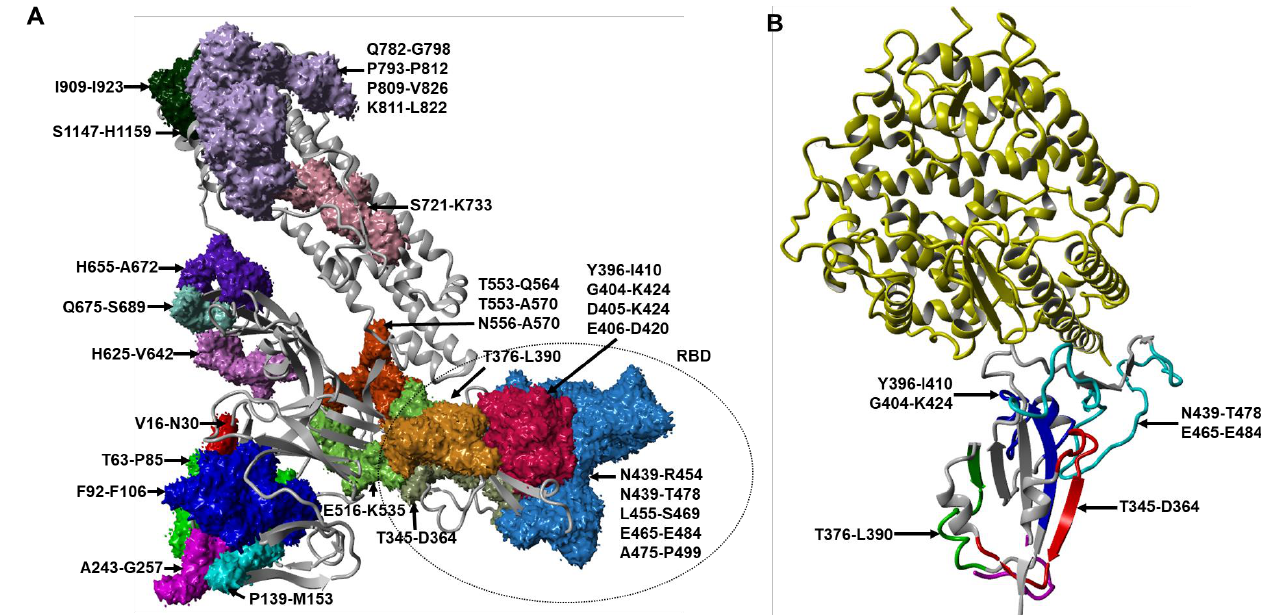
Figure 2. ( A ) The localization of B-cell epitopes mapped on the SARS-CoV-2 S monomer in closed conformation are represented by the amino residue number (PDB ID: 6ZB5/A). ( B ) Locations of B-cell epitopes targeted by monoclonal antibodies in the structure of ACE2 in complex with the SARS-CoV-2 RBD (PDB ID: 7DQA). ACE2 is shown in yellow, while the RBD is in grey colour.